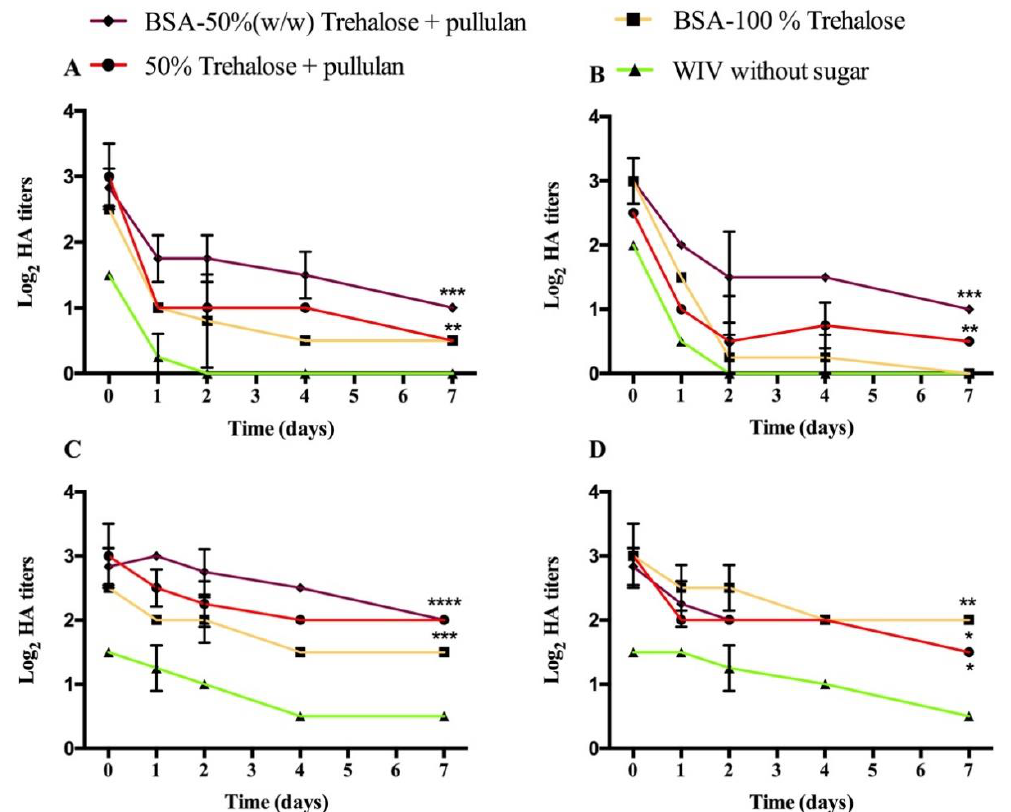
Figure 3. Process and storage stability of air- ( A and C ) and vacuum-dried ( B and D ) WIV dots up to 7 days at 60 ◦ C / 0% RH ( A and B ) or 30 ◦ C / 56% RH ( C and D ). Hemagglutination titers are represented as log 2 titers with significance indicated as * p < 0.05. ** p < 0.01.*** p < 0.001 and **** p <